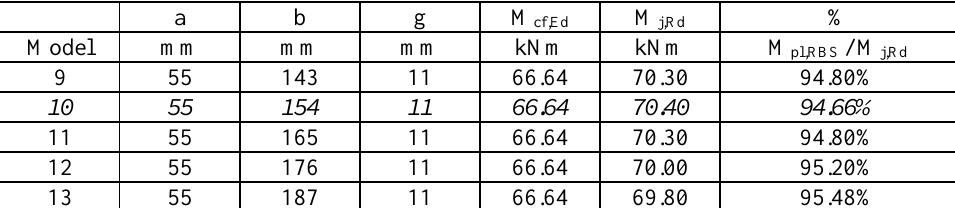
Results of stage 2 analysis.